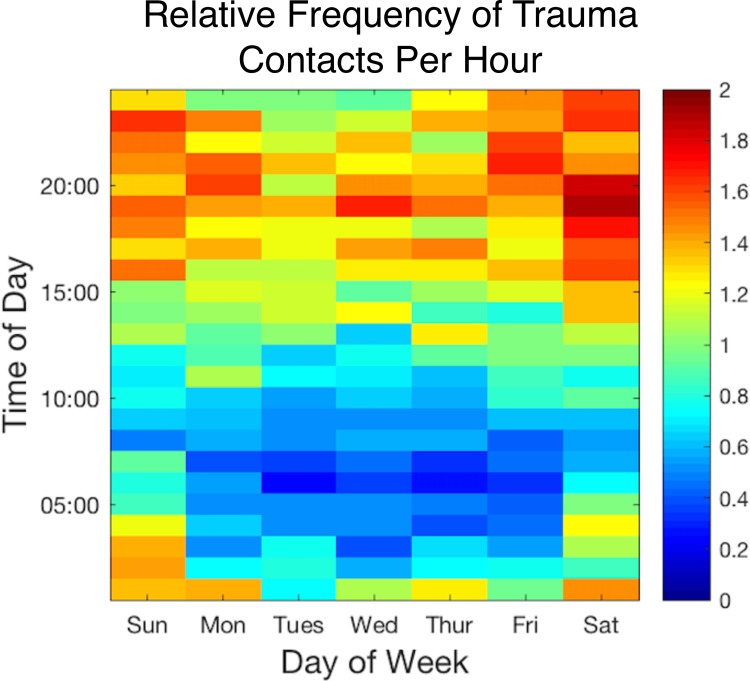
Heatmap of trauma admissions by time of day versus day of week.Each block of the heatmap represents a one hour block of one day of the week over the three year study period. The color corresponds to the relative frequency of contacts per hour as described by the color bar to the right of the image, where 1 represents the mean number of trauma contacts per hour. Weekend days have more trauma than weekdays, P<0.001. Mornings (4AM– 8AM) have less trauma than evenings (4PM– 8PM) on all days of the week, P<0.001.